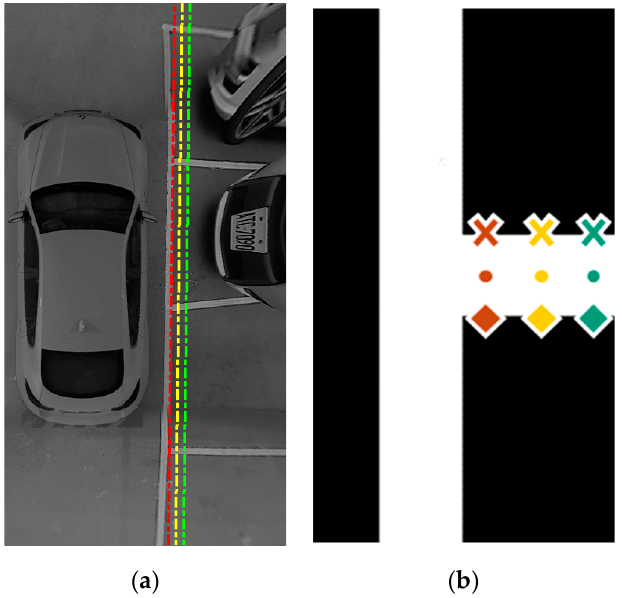
Figure 12. Sampling along the virtual lane boundary line: ( a ) virtual lane boundary line; ( b ) white-to-black (W2B) and black-to-white (B2W) interfaces.